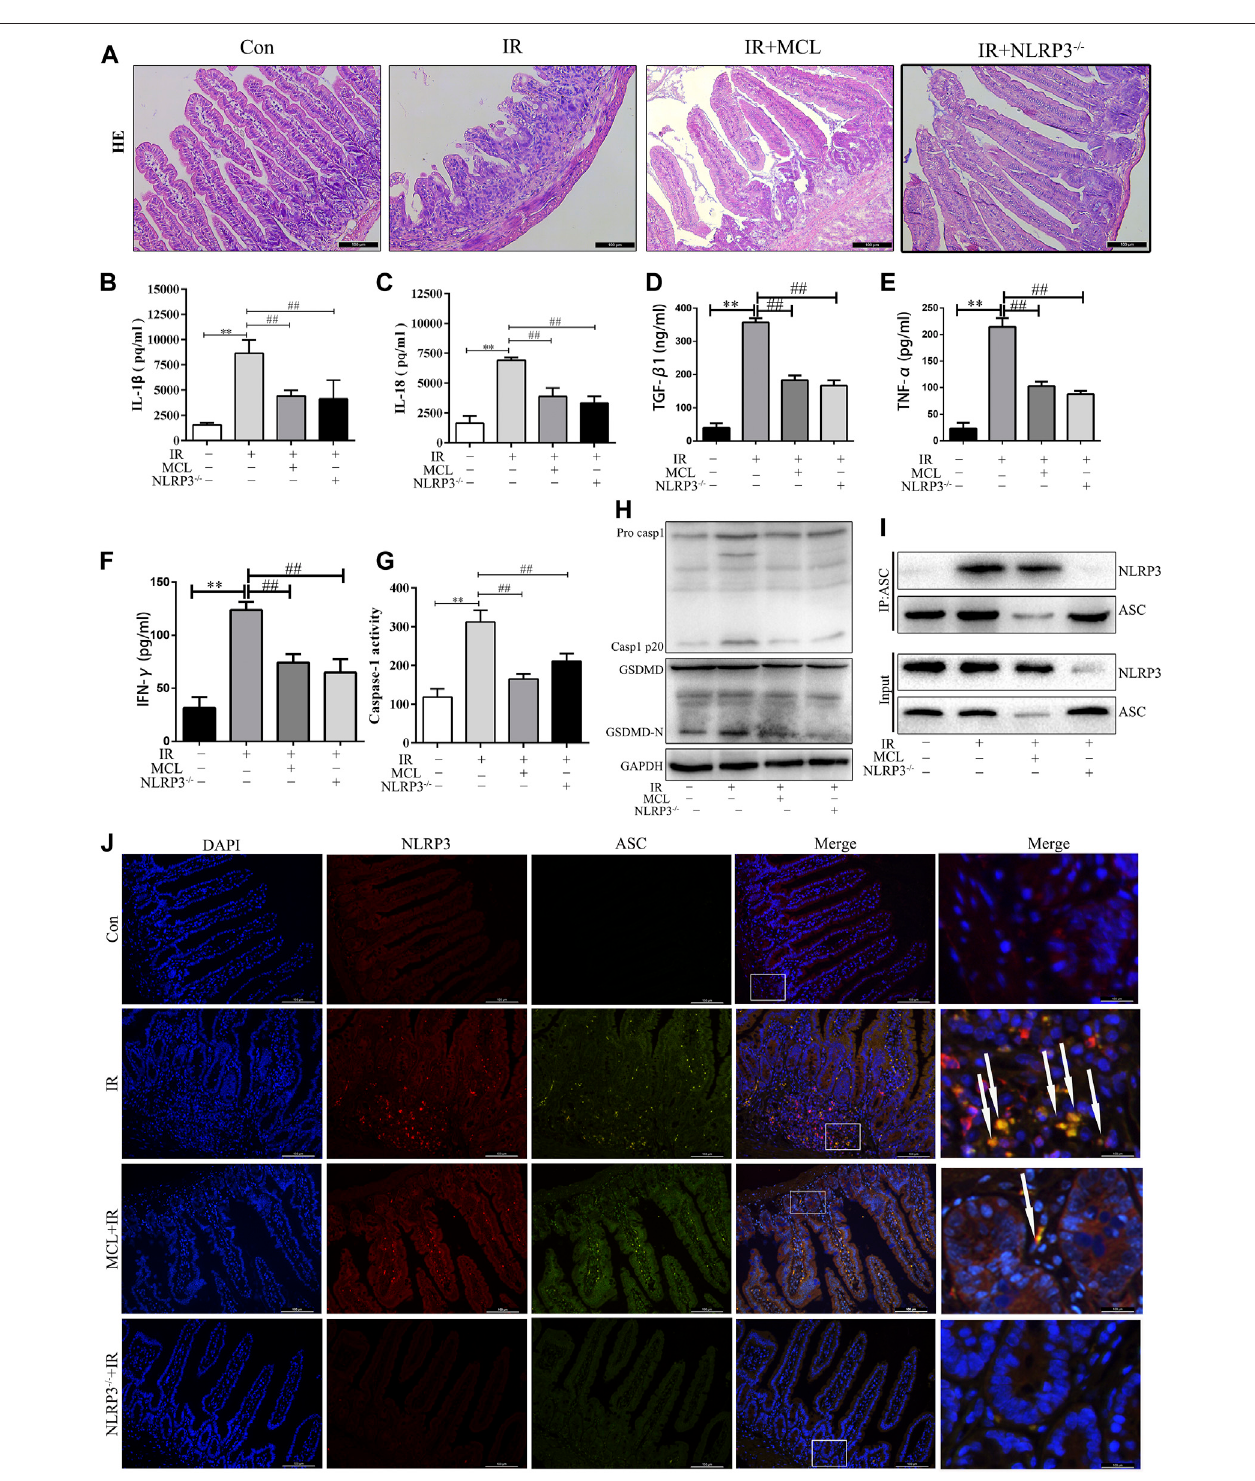
FIGURE 4 | Micheliolide (MCL) inhibited irradiation-induced NLRP3 in fl ammasome activation in mice (A) Representative small intestine hematoxylin and eosin staining from NLRP3 − / − and wild-type (WT) mice following irradiation (B) Serum IL-1 β levels in NLRP3 − / − and WT mice following irradiation (C) Serum IL-18 levels in NLRP3 − / − andWTmicefollowingirradiation(D)SerumTGF- β 1levelsinNLRP3 − / − andWTmicefollowingirradiation (E) SerumTNF- α levelsinNLRP3 − / − andWTmice following irradiation (F) Serum IFN- γ levels in NLRP3 − / − and WT mice following irradiation (G) Caspase-1 activity in the small intestine of NLRP3 − / − and WT mice treated with MCL following irradiation (H) Expression of pro-casp1, casp1 p20, GSDMD, and GSDMD-N in NLRP3 − / − and WT mice treated with MCL following